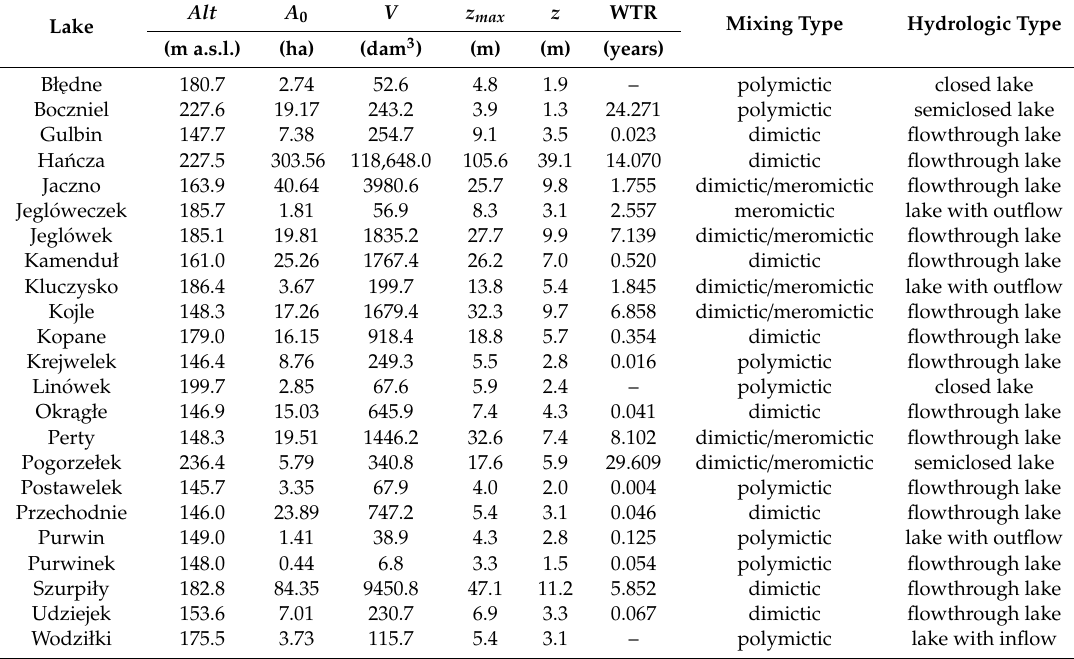
Table 1. Basic morphometric characteristics of the Suwałki Landscape Park lakes, and their division based on mixing and hydrology. Denotations: Alt —geodetic elevation of the water surface, A 0 —lake water surface area (without islands), V —lake volume, z max —maximum depth, z —mean depth, and WRT—water residence